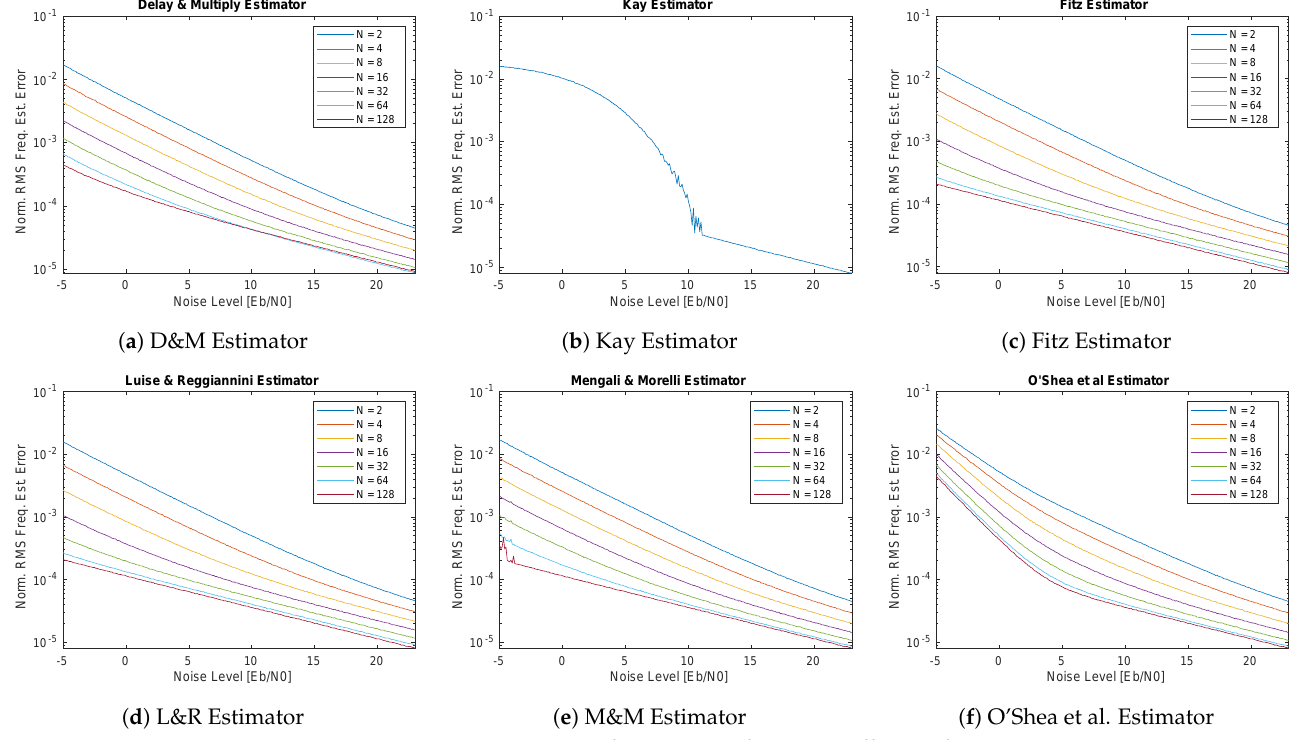
Figure 17. Frequency Estimators Performance, no frequency offset, E b / N 0